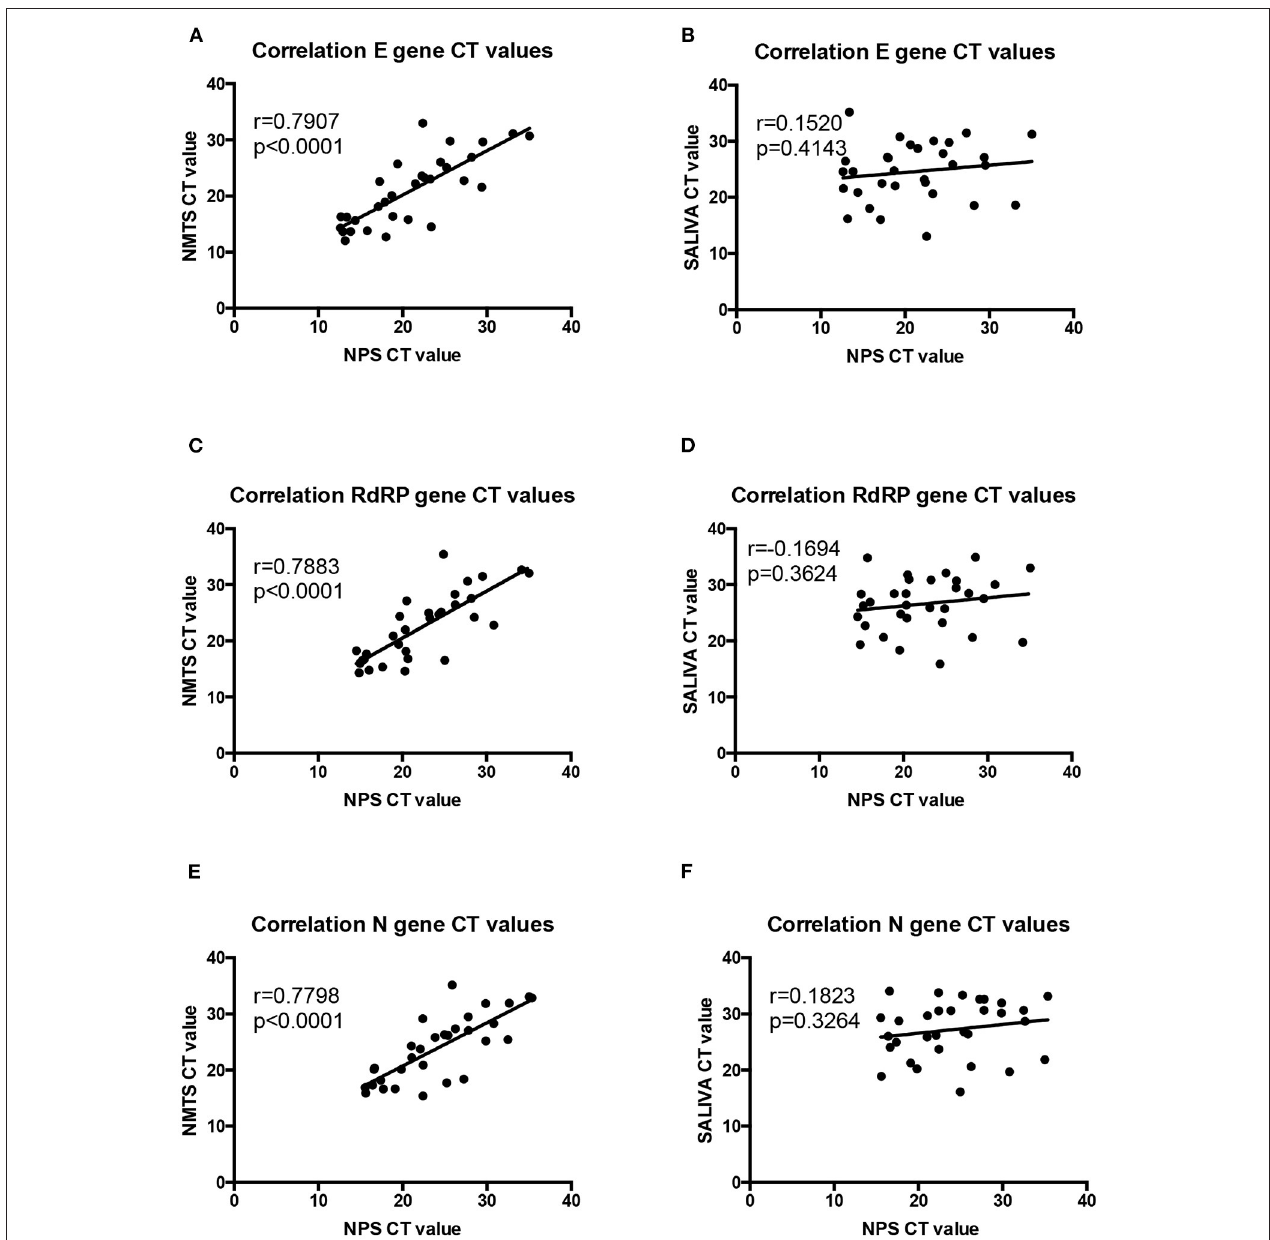
FIGURE 2 | Comparison of the RT-qPCR efficiency between the distinct sampling methods. Correlation of SARS-CoV-2 Cycle threshold (Ct) values obtained for (A,B) E target gene, (C,D) RdRP target gene, (E,F) and N target gene between nasopharyngeal swab (NPS), nasal mid-turbinate swab (NTMS), and saliva (SALIVA) samples. NPS was considered as the sampling method